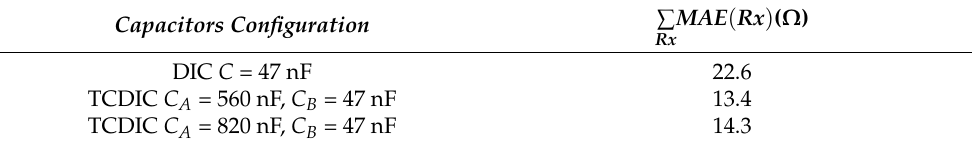
Table 2. The table shows the sum of the Maximum Absolute Errors for each capacitor